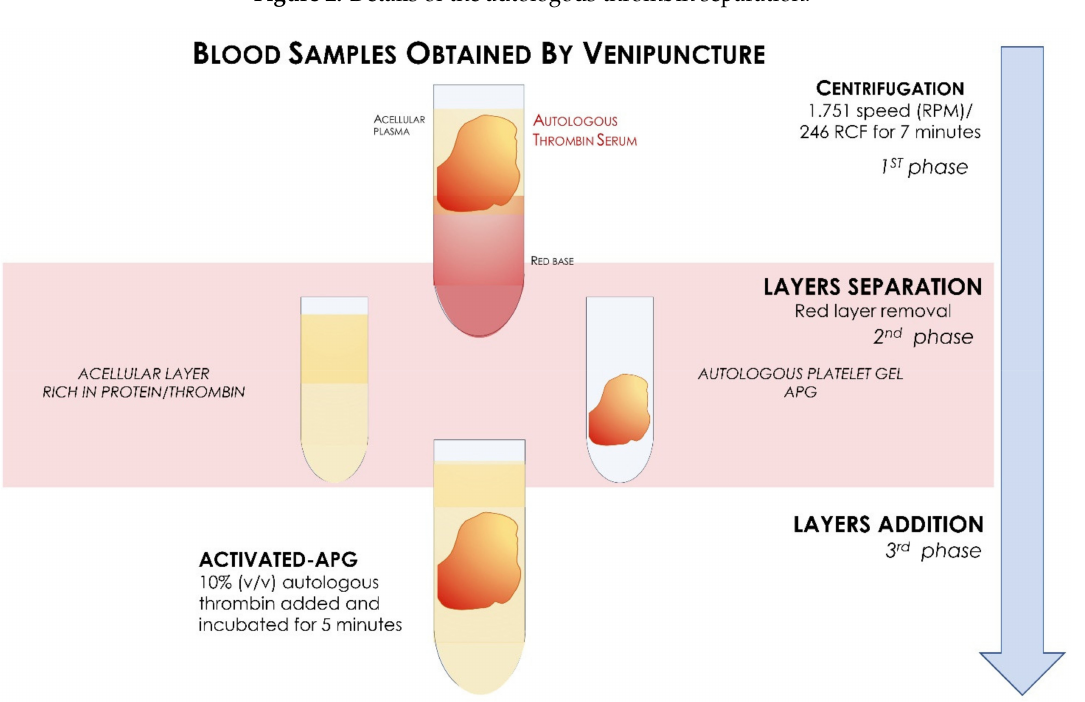
Figure 2. Details of the autologous thrombin separation.